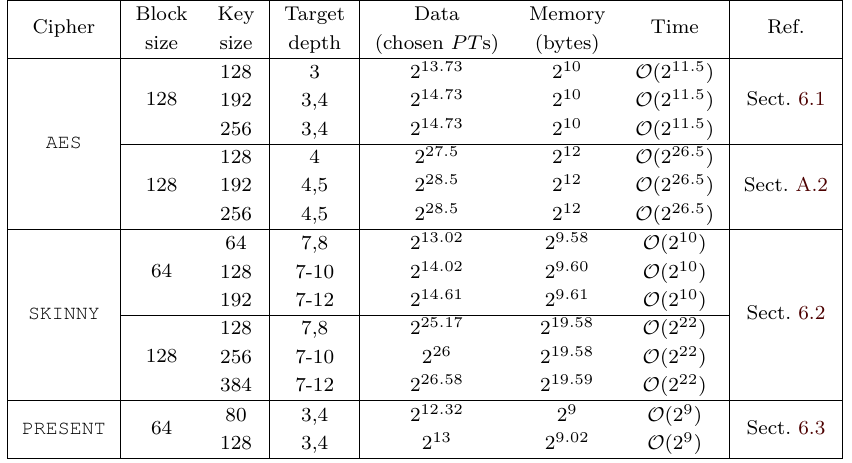
Table 2: Summary of attack complexities on various